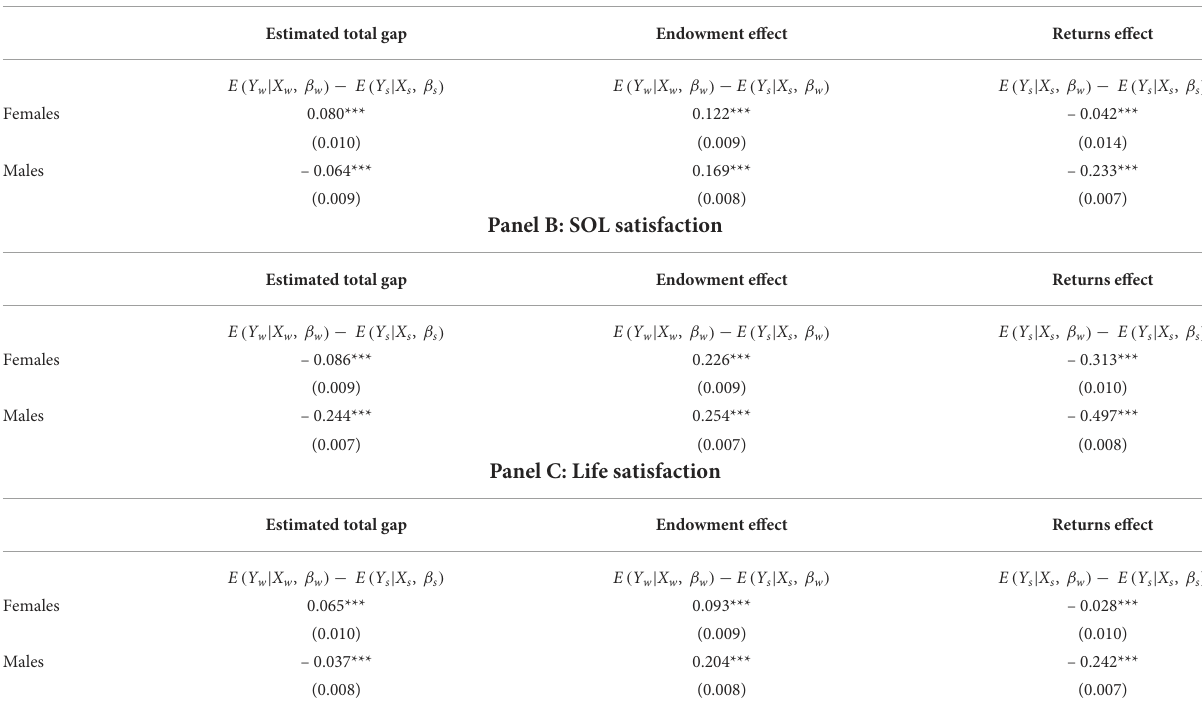
TABLE 4 Well-being difference between self-employed and wage-employed: endowments and returns